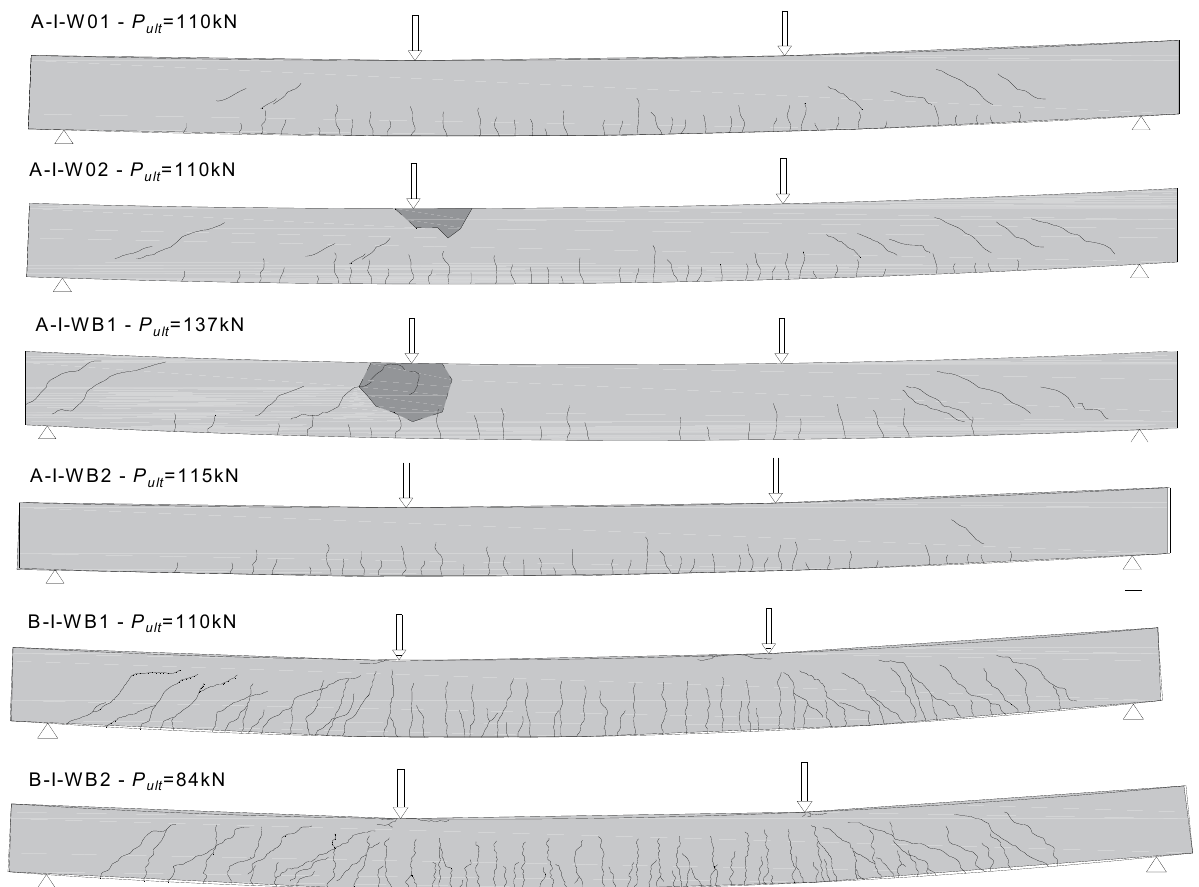
Figure 4. Crack patterns of the tested beams at failure.